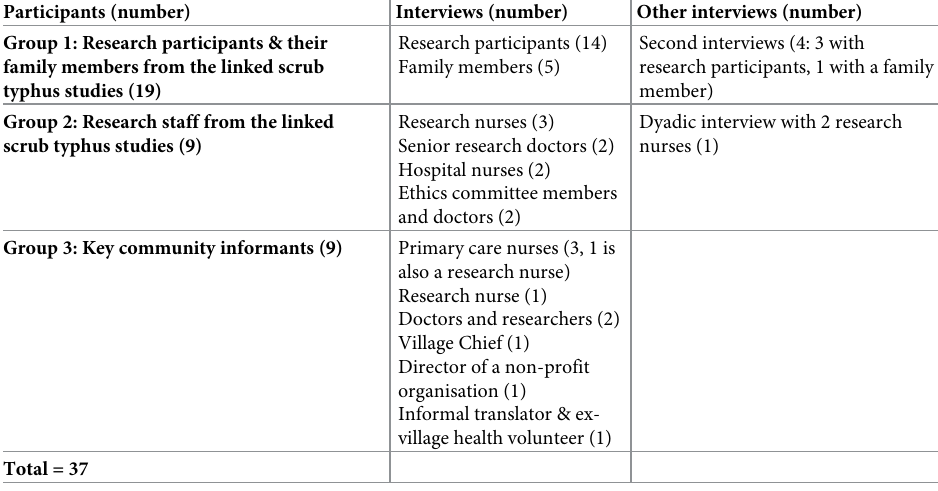
Table 2. Breakdown of REACH research